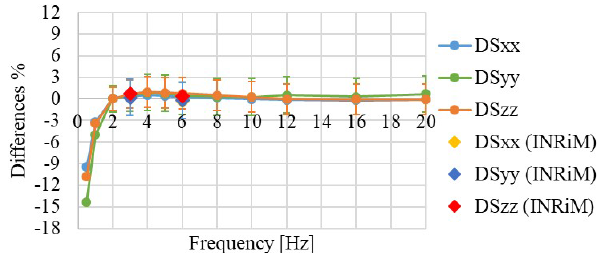
Figure 7. Sensitivity differences for the IEPE accelerometer, ac- quired by the IEPE module, in IEPE AC coupled